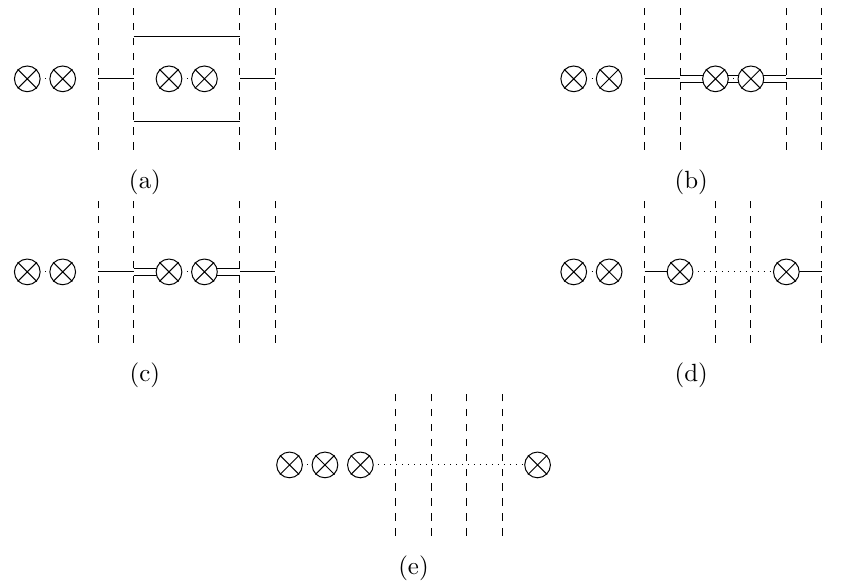
Figure 25. A [ A 1 1 KP transition from minimal of so ( 4 ) to trivial. (a) Higgs branch brane [ (cid:22) O II con(cid:12)guration of the model with M H = (cid:22) O I . (b) Critical point where the D3-brane (2 ; 2) (2 ; 2) coincides with the orientifold plane. (c) The D3-brane splits in three segments, the middle one is taken to in(cid:12)nity along the ~x directions. The result is a new model with a di(cid:11)erent Higgs branch. (d) Two phase transitions are performed to remove the remaining (cid:12)xed D3-brane segments. (e) The collapse transition is performed. The interval numbers of the half NS5-branes are ~k s = (0 ; 0 ; 0 ; 4), corresponding to the partition of the trivial orbit (cid:21) = (1 ; 1 ; 1 ;